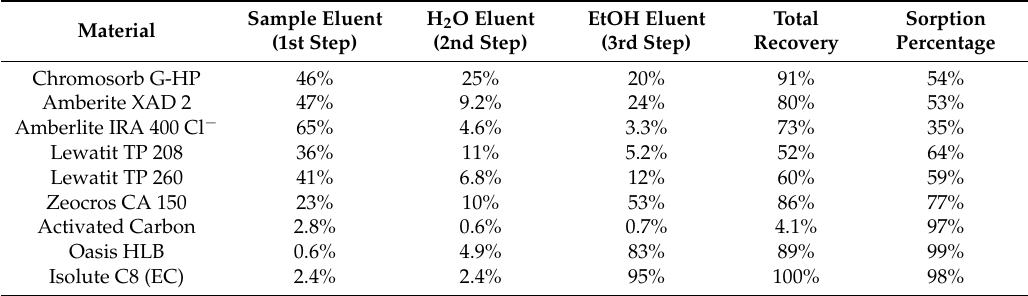
Table 2. Anthocyanins determined in the eluents in comparison with the anthocyanins loaded to the SPE column.